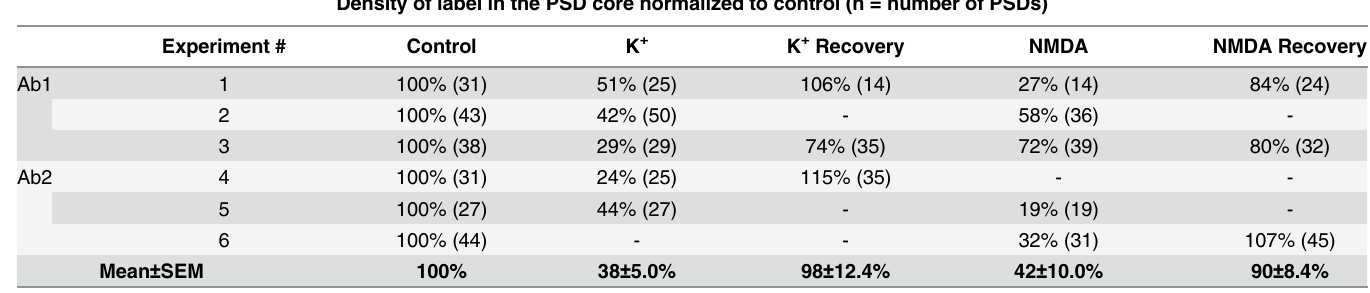
Table 1. AIDA-1 label density at the PSD core decreases under excitatory conditions and returns to basal levels within 30 min after cessation of the stimulus. Density of label in the PSD core normalized to control (n = number of